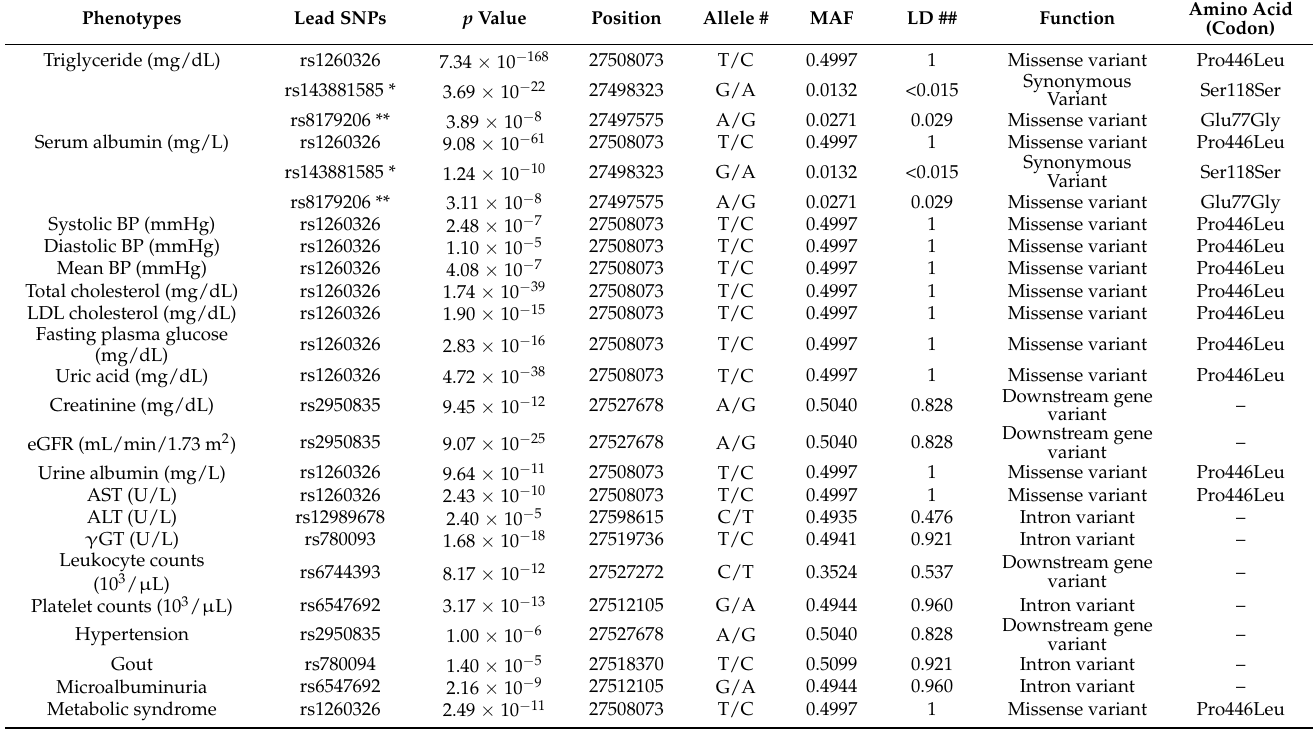
Table 3. Lead single-nucleotide polymorphisms at the GCKR gene